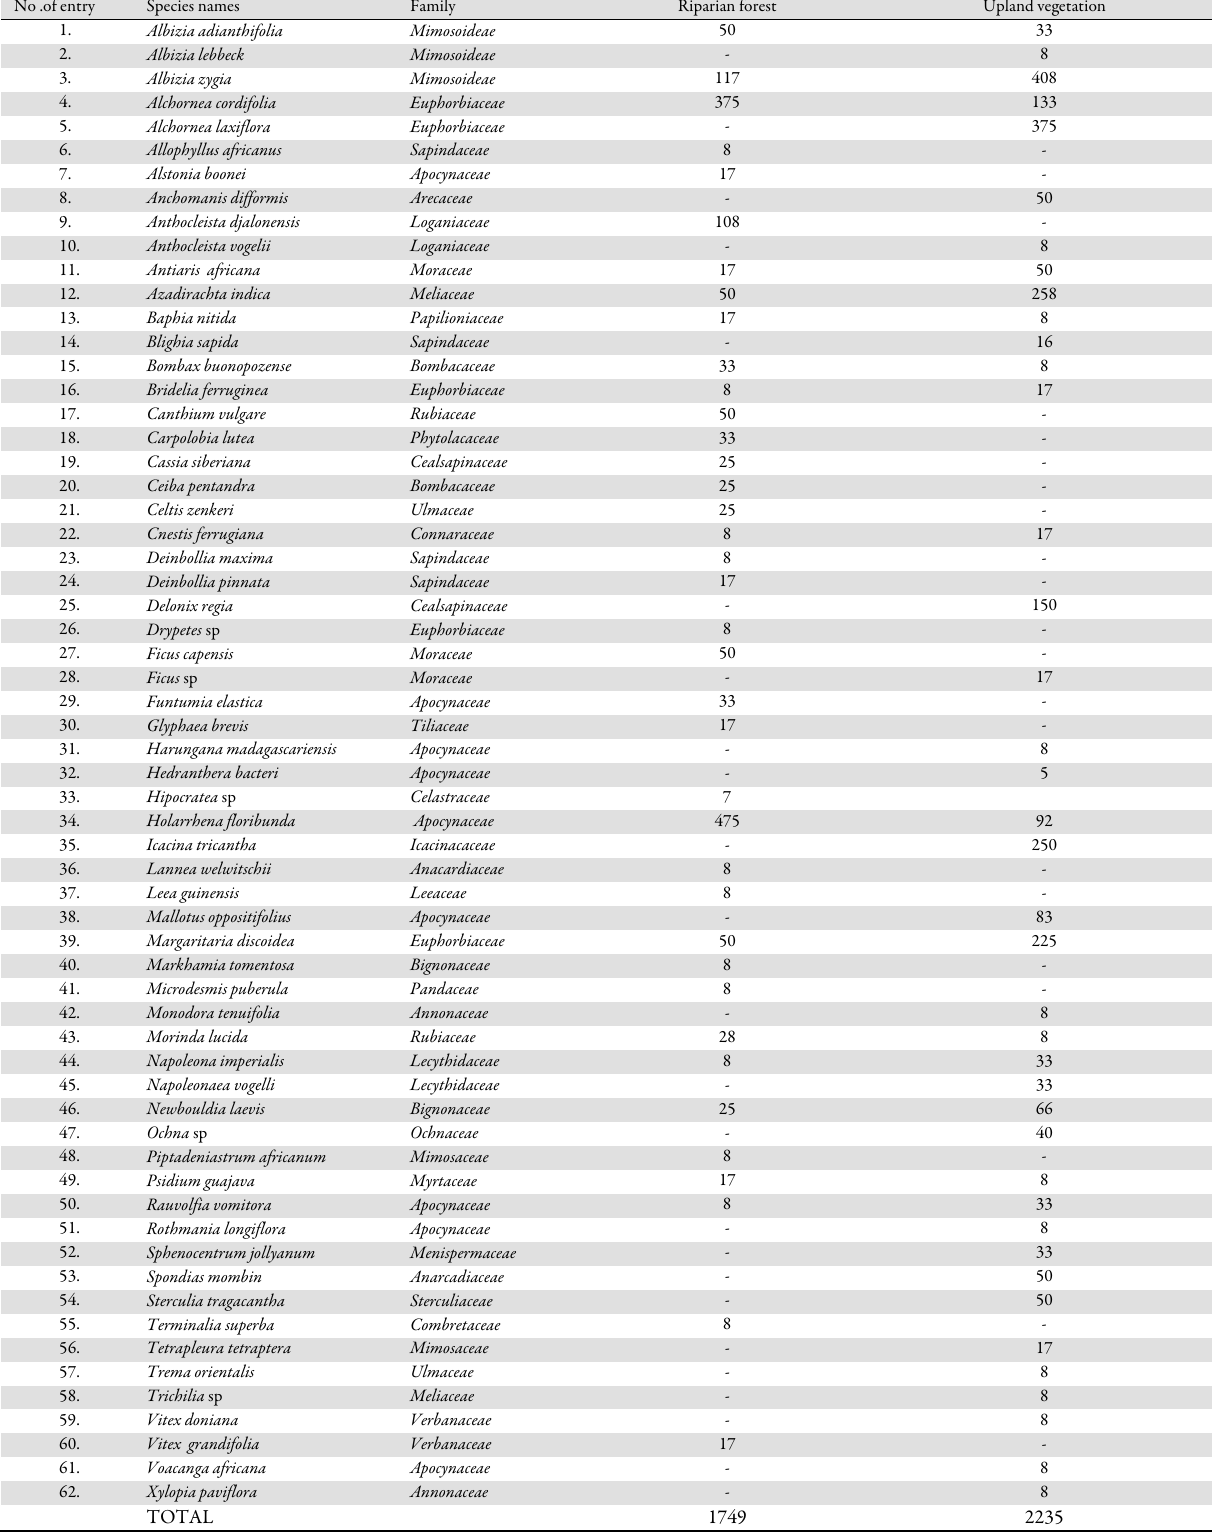
Table 1. Mean density of woody species (per hectare) in the two vegetation types No .of